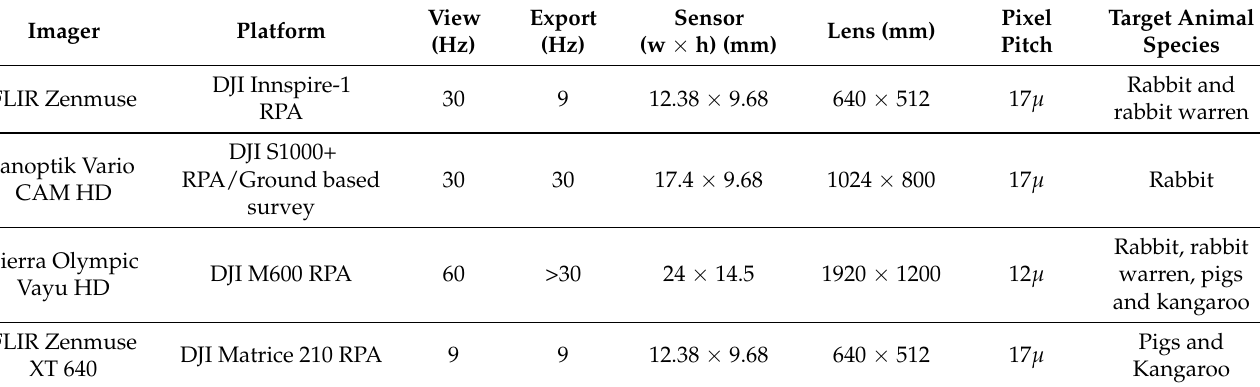
Table 1. The types and specifications of the thermal imagers that collected the footage that was used for this study. Imager